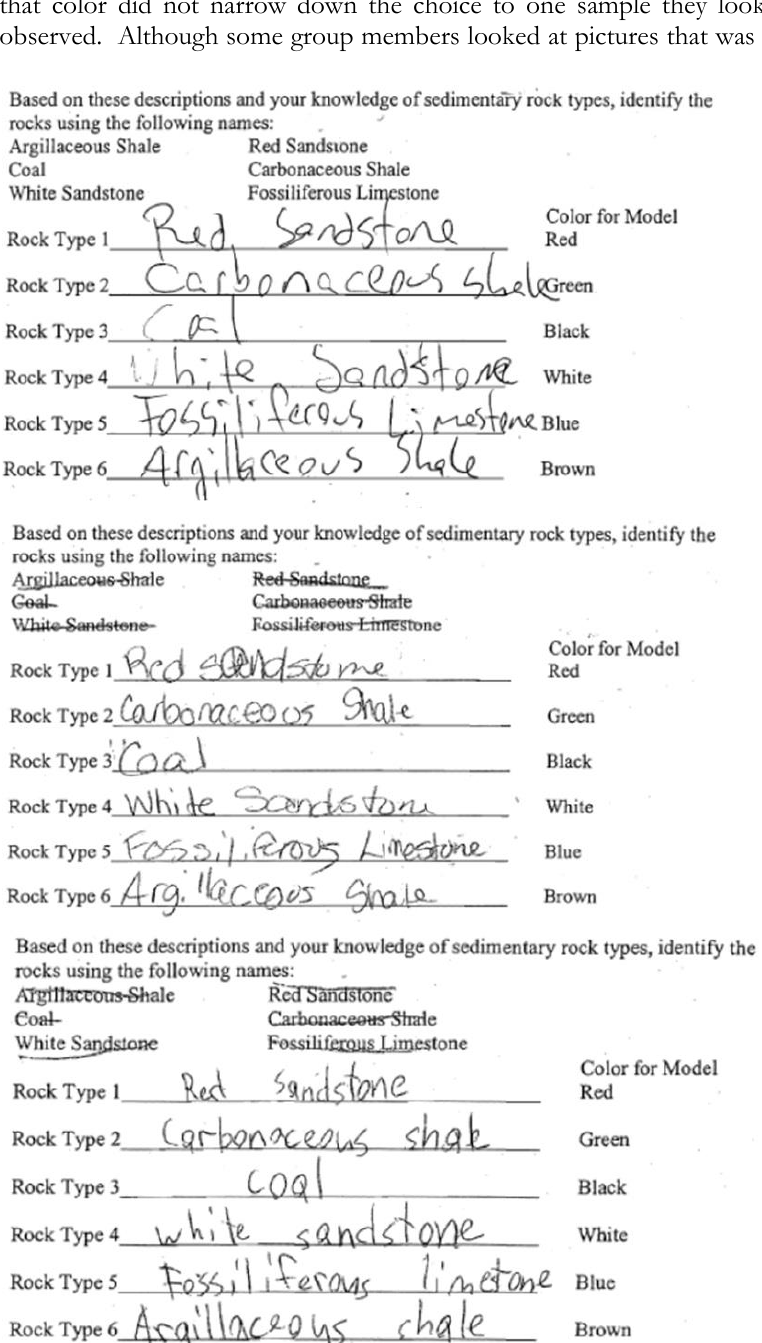
Figure 1. Student sample